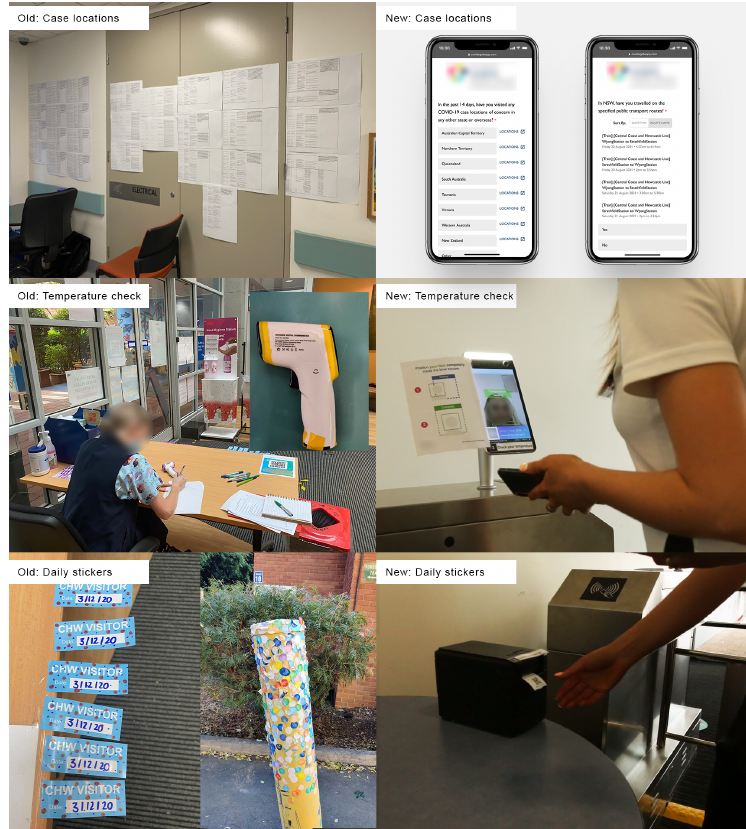
Figure 1. Comparing the manual system with the eGate system.